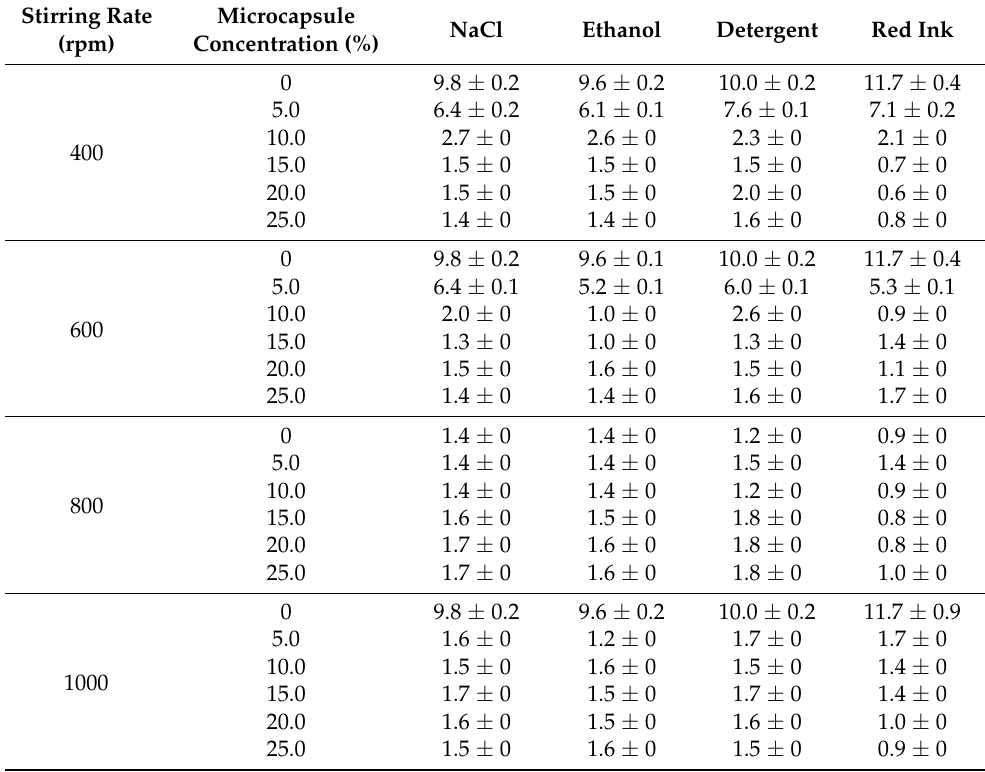
Table 7. The gloss of waterborne primer film after liquid